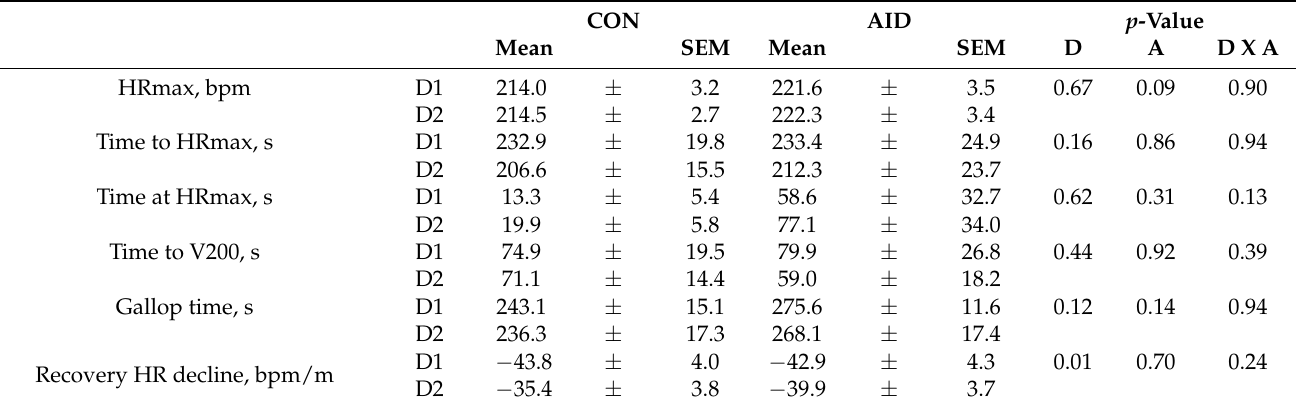
Table 3. Heart rate (HR) and performance parameters for adult horses consuming a placebo (CON) or recovery aid (AID) and completing a standardized exercise test to fatigue at 48 h intervals 1 .